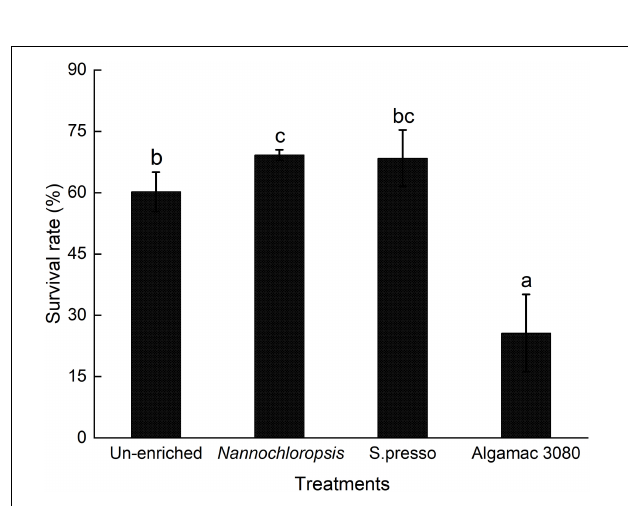
FIGURE 4 | Jaw deformity rate of golden pompano larvae in four enrichment treatments.